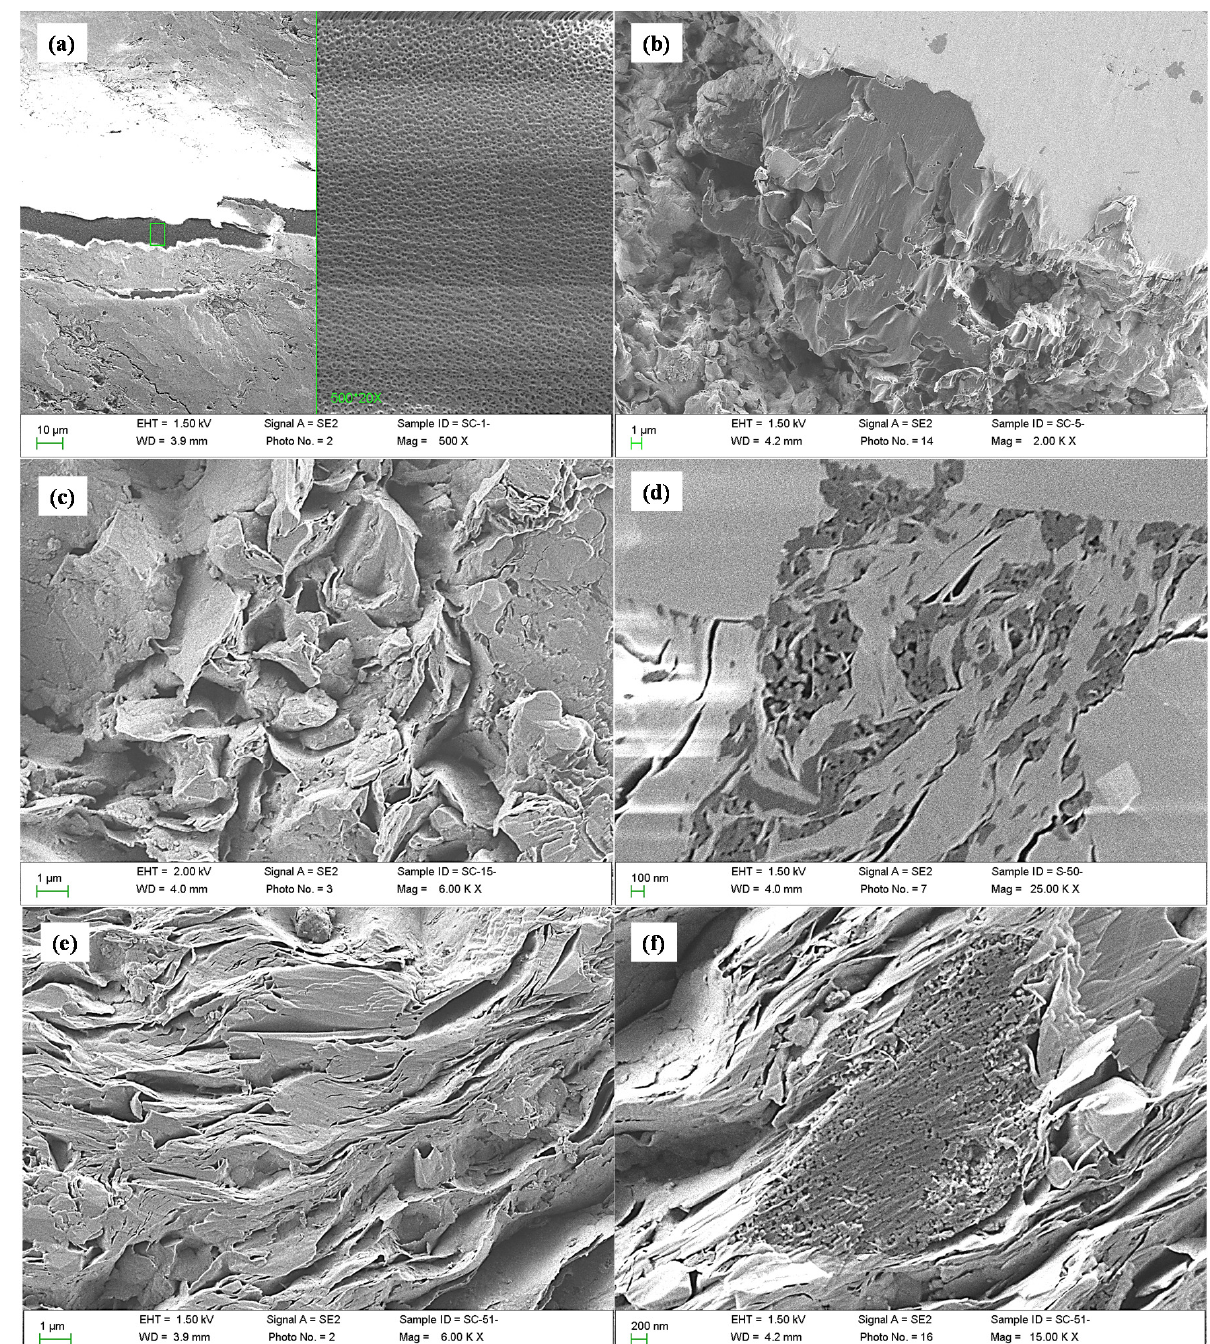
Figure 4. Microscopic characteristics of shale pores in the Dawuba Formation of Well QSD-1. ( a ) Black shale, member 4 of the Dawuba Formation, 1490 m, banded organic matter developed, micropores developed inside; ( b ) black shale, member 3 of the Dawuba Formation, 1531 m, organic matter is distributed in mineral grains, pores are developed in its interior and edge and some pores are connected to each other; ( c ) black shale, member 3 of the Dawuba Formation, 1660 m, clay mineral intergranular pore development; ( d ) black shale, member 2 of the Dawuba Formation, 1930 m, mixed distribution of organic matter and clay minerals; ( e ) black shale, member 1 of the Dawuba Formation, 1940 m, clay mineral interlayer fractures developed in a narrow strip; ( f ) black shale, member 1 of the Dawuba Formation, 1940 m, clay mineral interlayer fractures and micropores developed.